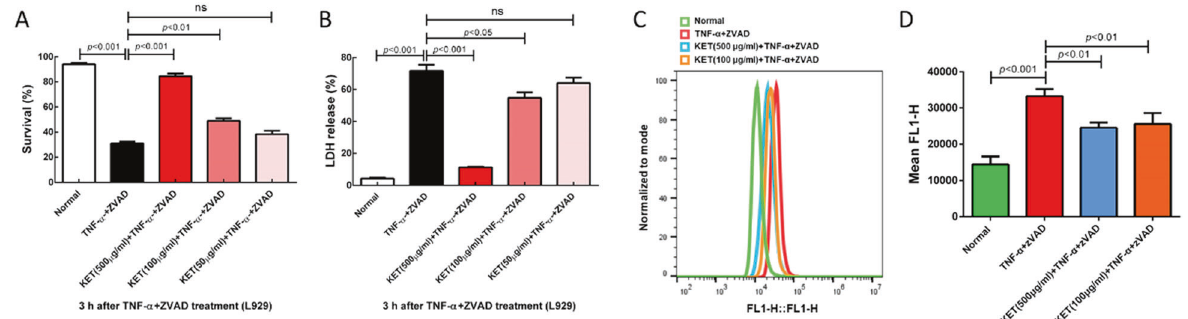
Fig. 5 The effect of ketamine on TNF-induced damage and ROS accumulation in L929 cells. L929 cells were treated with nothing (Normal group), TNF- α + ZVAD, or TNF- α + ZVAD plus different doses of ketamine as indicated for 3 h. A The survival rates of cells were determined by